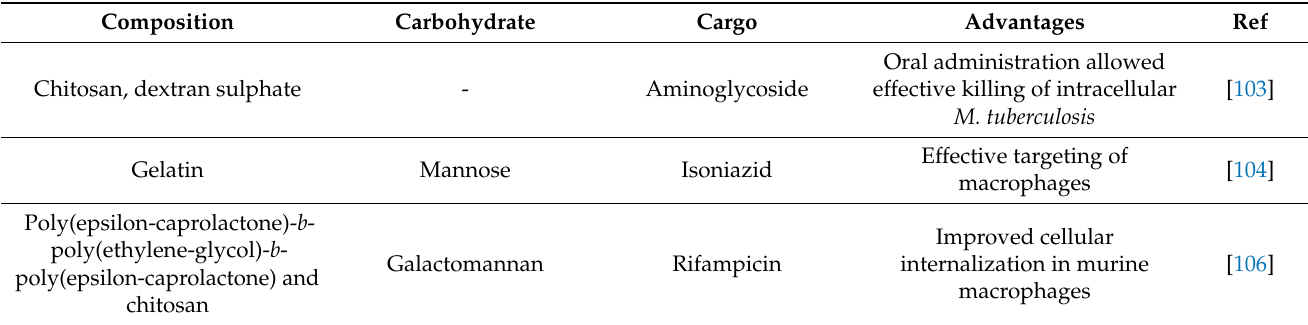
Table 2. Mannose receptor-targeting nanocarriers towards infection